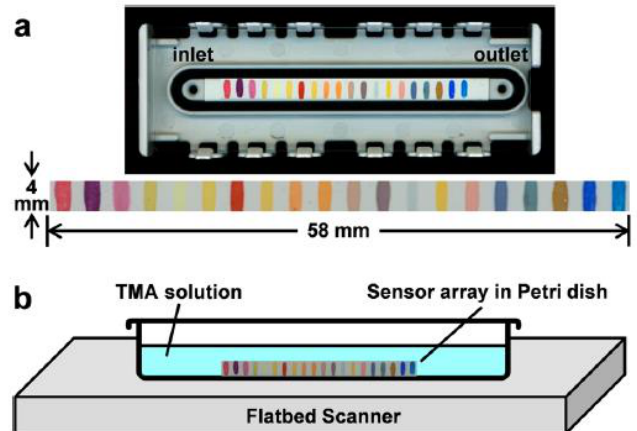
Figure 14. Colorimetric sensor array for trimethylamine (TMA) detection. ( a ) Linearized 20-element sensor array for vapor detection; ( b ) schematic of the experimental setup consisting of a closed Petri dish containing 10 mL of a buffered aqueous TMA solution, an array positioned in the solution, and an ordinary flatbed scanner for imaging [97].